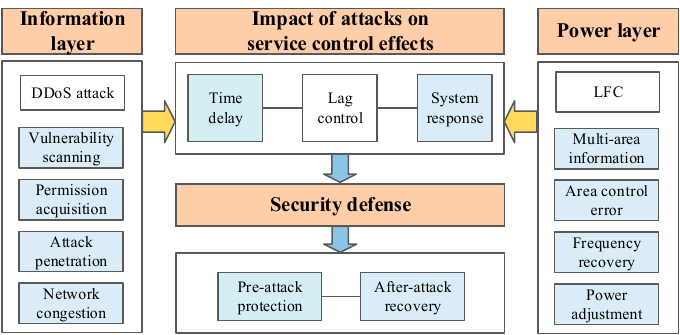
Figure 2. Framework of the attack and defense process.